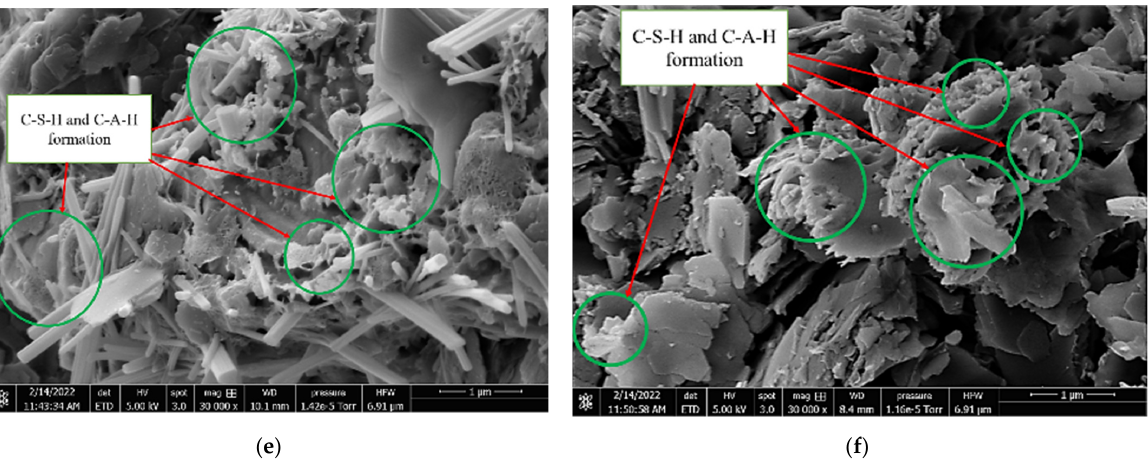
Figure 4. ( a ) Scanning Electron Microscopy (SEM) image results for ASS 1 after 7 days of curing; ( b ) SEM image results for ASS 2 after 7 days of curing; ( c ) SEM image results for ASS3 after 7 days of curing; ( d ) SEM image results for ASS 1 after 28 days of curing; ( e ) SEM image results for ASS 2 after 28 days of curing; ( f ) SEM image results for ASS 3 after 28 days of curing.